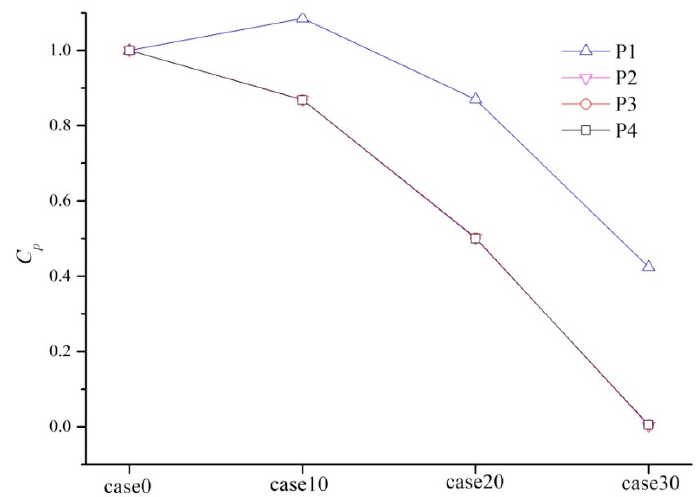
Figure 13. Evolution of amplitude coefficients of pressure fluctuation at f BP for different cases.